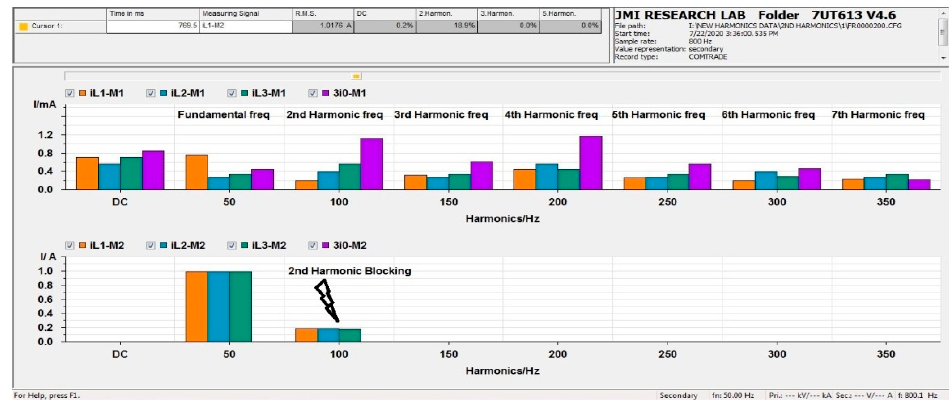
Figure 10. 2nd HB at 1000 mA Rated current & 20% of Inrush current condition.